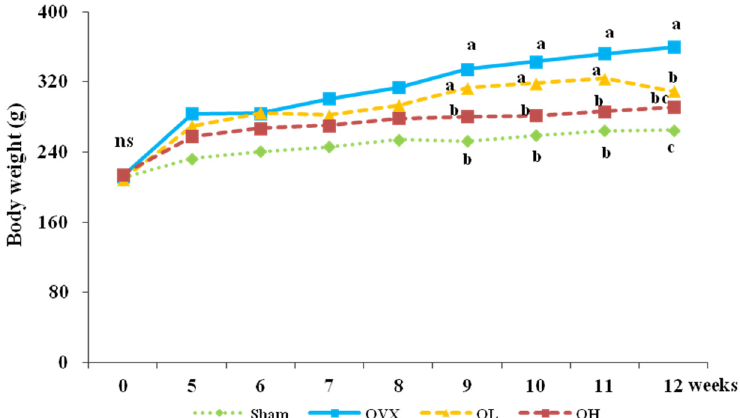
Figure 1. Body weight change of each group. Values are mean ± SD ( n = 7 for each group). The different letters (a > b > c) within a column indicate significant differences ( p < 0.05) determined by Duncan’s multiple range test; Sham, the non-OVX control; OVX, the OVX-control; OL, the OVX + 100 mg/kg b.w. of hawthorn extract; OH, the OVX + 200 mg/kg b.w. of hawthorn extract.